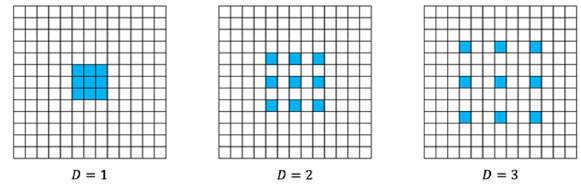
Figure 3. Standard convolution with 3 × 3 kernel size and dilated convolution. D = 1 is the same as the standard convolution. D = 2, 3 are calculated by placing zero padding inside the kernel, as shown in the figure.